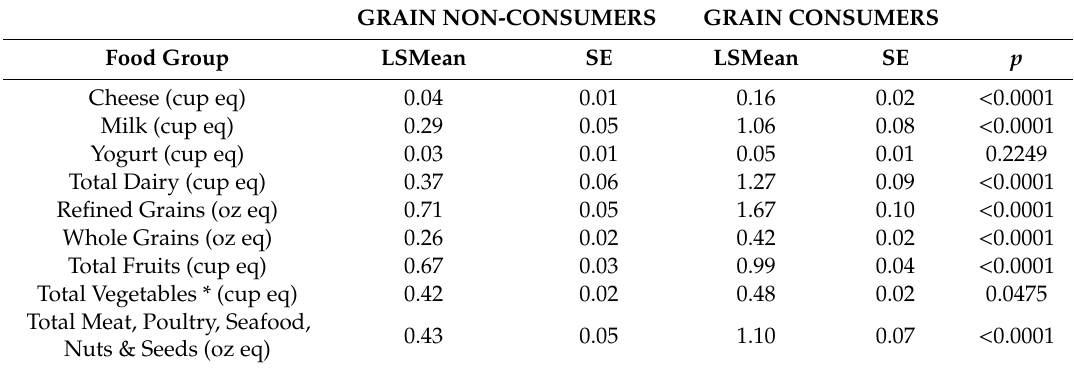
Table 5. Mean (SE) food group intake for 6- to 12-month-old grain consumers vs. grain